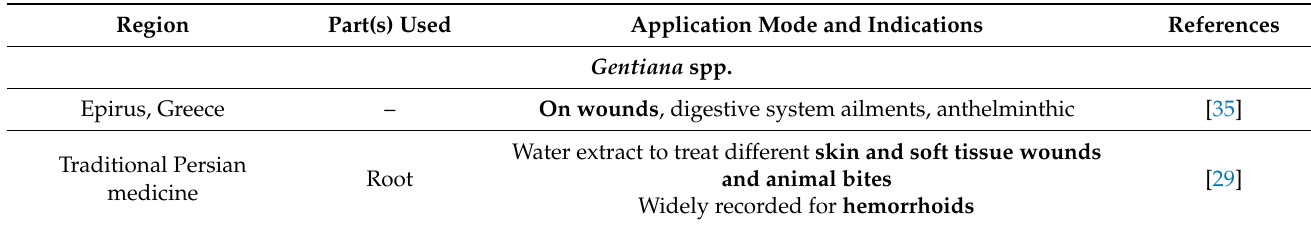
Table 1. Application of Gentiana species in various traditional medicines and regions. Region Part(s) Used Application Mode and